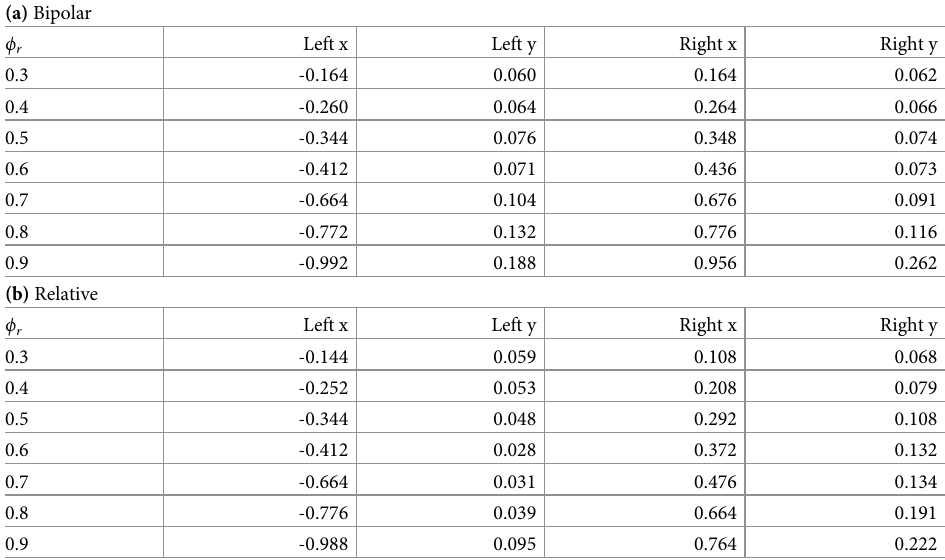
Table 1. The coordinates for the peaks for the (a) Bipolar and (b) Relative